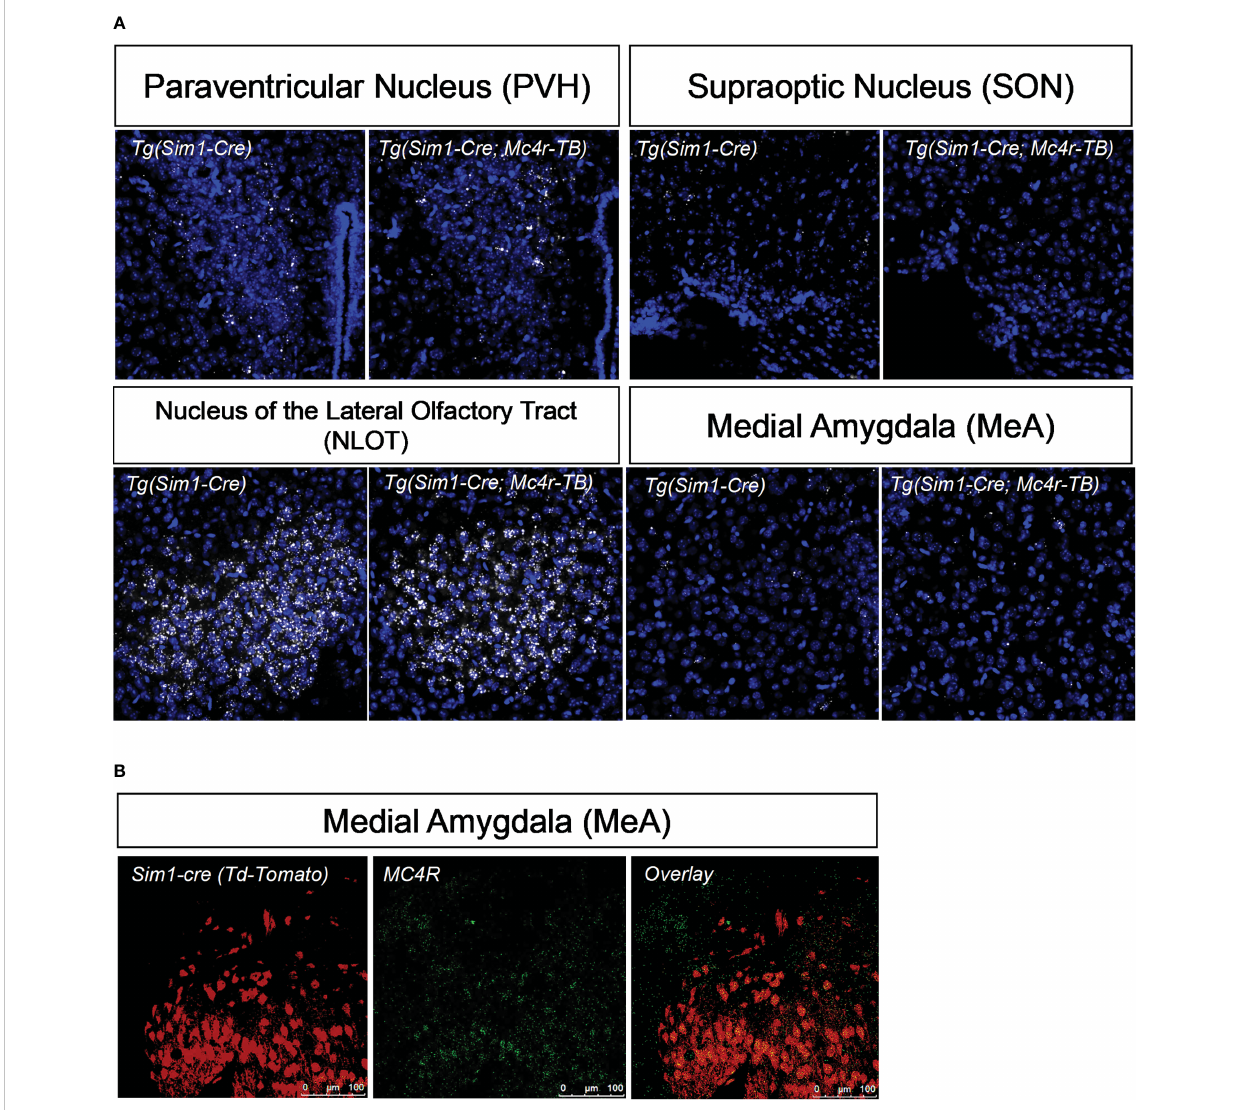
FIGURE 2 MC4R re-expression and colocalization with Sim1. (A) Using in situ hybridization, mRNA of MC4R in tbMC4R Sim1 mouse brains was con fi rmed in the paraventricular hypothalamus (PVH), the nucleus of the olfactory tract (NLOT), and the medial amygdala (MeA). MC4R mRNA is labelled white. Nuclei were labelled using DAPI (blue). (B) Using immunohistochemistry, co-localization between MC4R and Sim1-cre driven tdTomato expression was con fi rmed in the MeA of Sim1-cre mice. Sim1 (tdTomato) labelled red; MC4R labelled